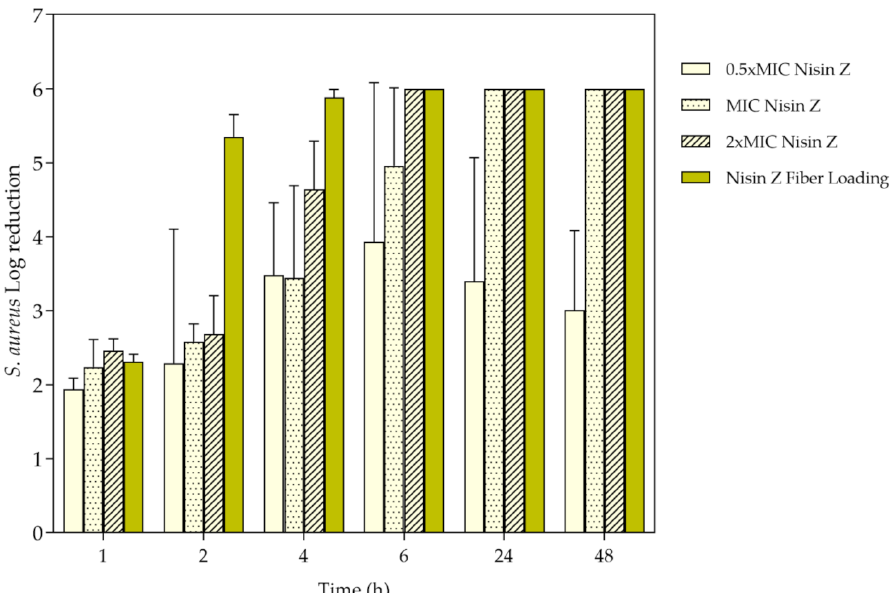
Figure 7. S. aureus log reduction in contact with Nisin Z in its free state at 0.5, 1 and 2 × Minimum Inhibitory Concentration (MIC) and at the loading concentration in the fibers, after 1, 2, 4, 6, 24, and 48 h of culture. Data derived from three repetitions (mean ±